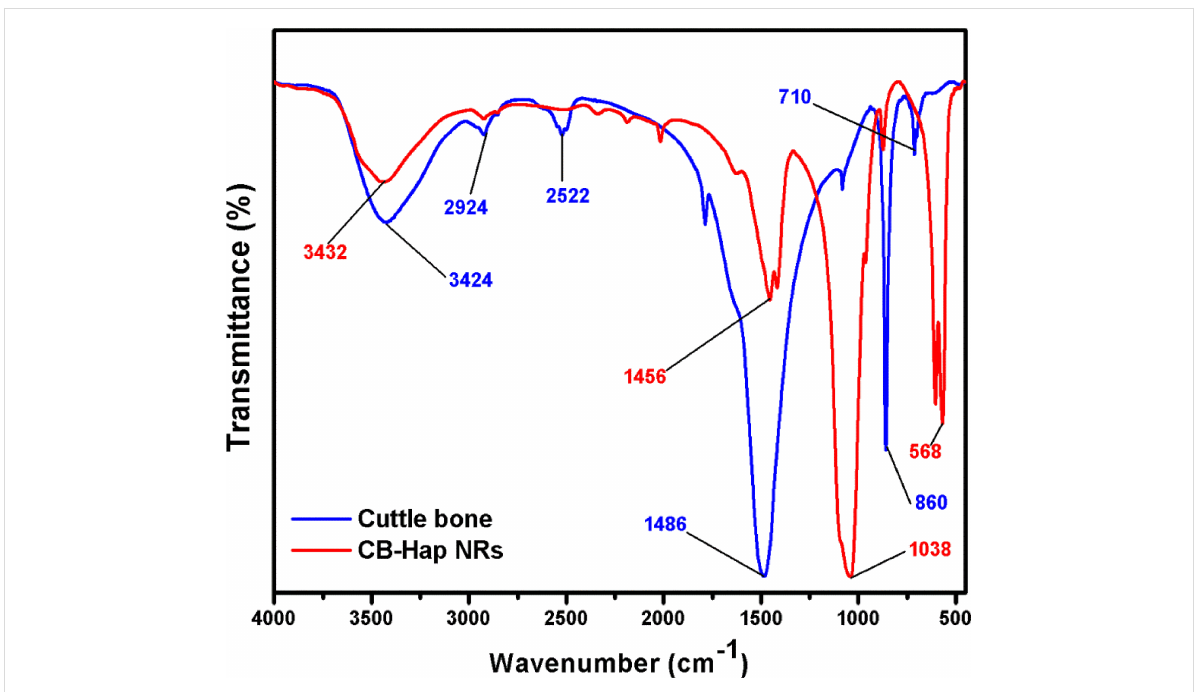
Figure 2: FTIR spectra of cuttlefish bone and hydroxyapatite (Hap) nanorods using cuttlefish bone powder as a precursor (CB-Hap NRs).